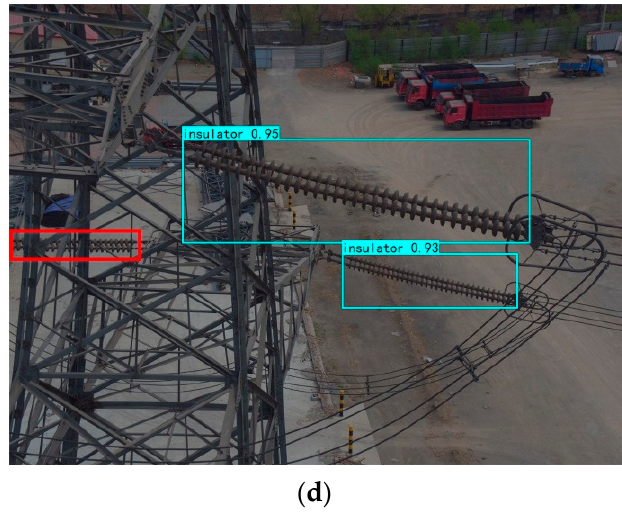
Figure A6. Some detections missed by ECA-YOLOX-Tiny: ( a ) the missing detection of insulator defect target, ( b ) The missing detection of overlap small target 1, ( c ) the missing detection of overlap small target 2, ( d ) the missing detection of serious occlusion target.